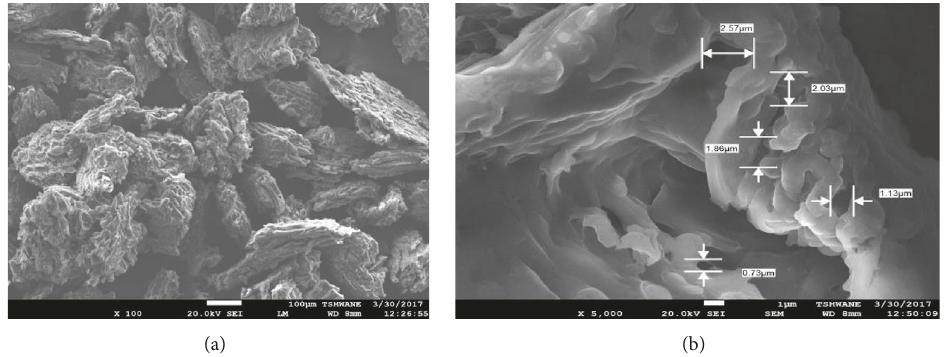
Figure 7: (a) Overview of 𝐵 1 from SEM analysis; (b) pore size distribution of 𝐵 1 at × 5000 magnification.